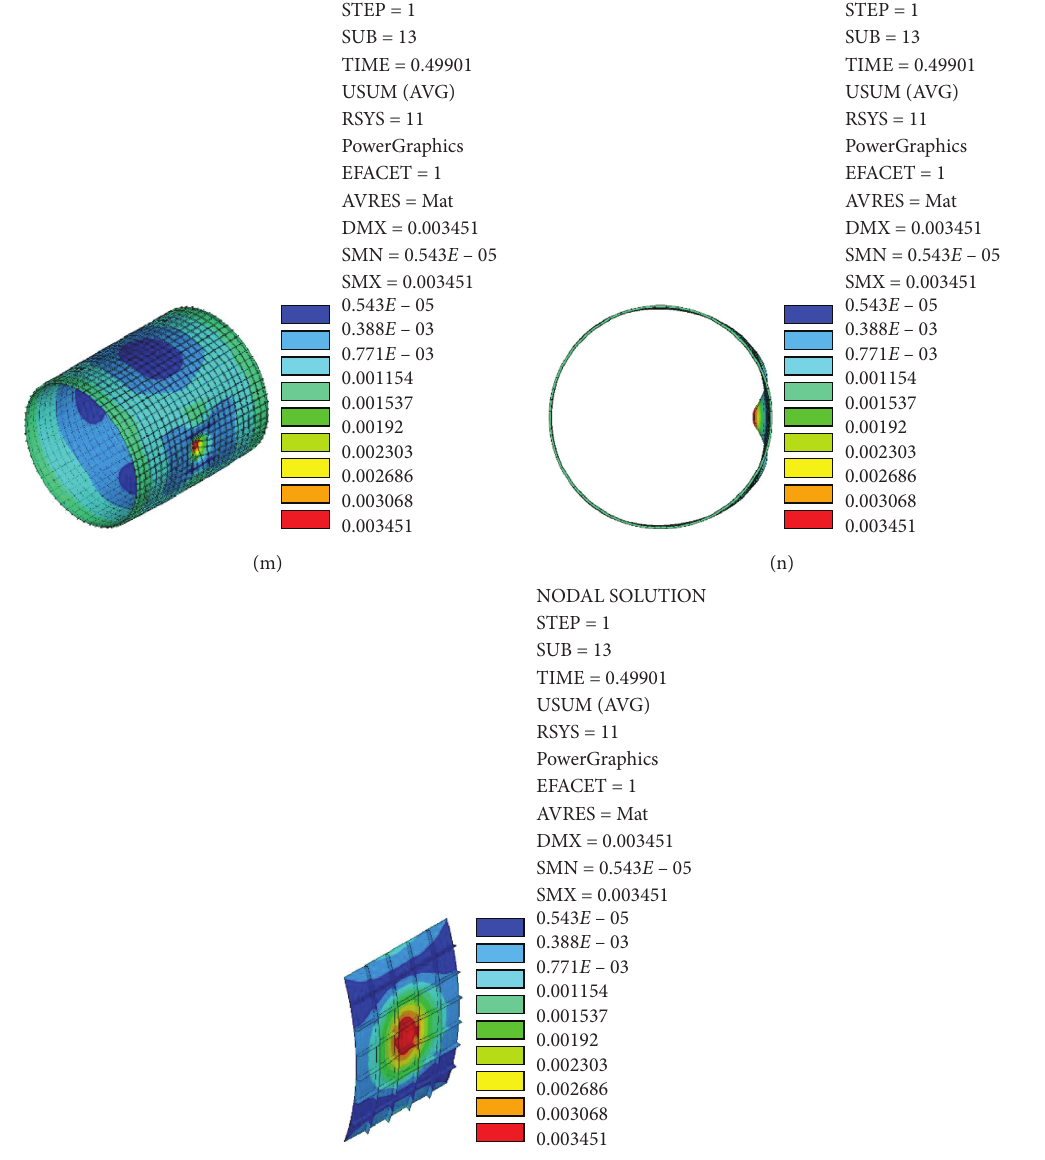
� 0.060m and δ � 0.5 t . (a) Oblique m 0